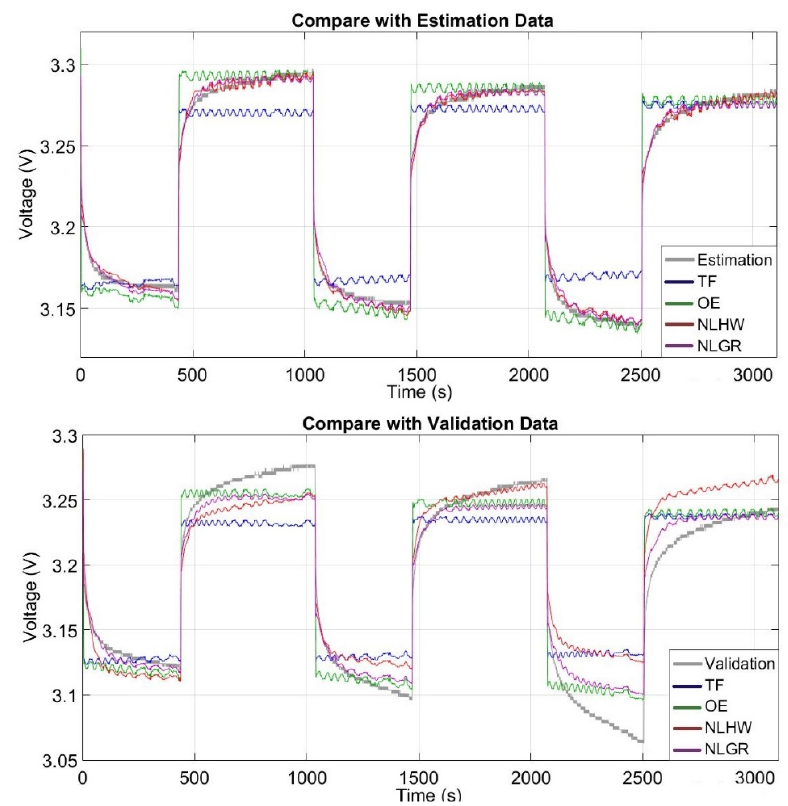
Figure 6. Comparison between each model response against estimation data and validation data.